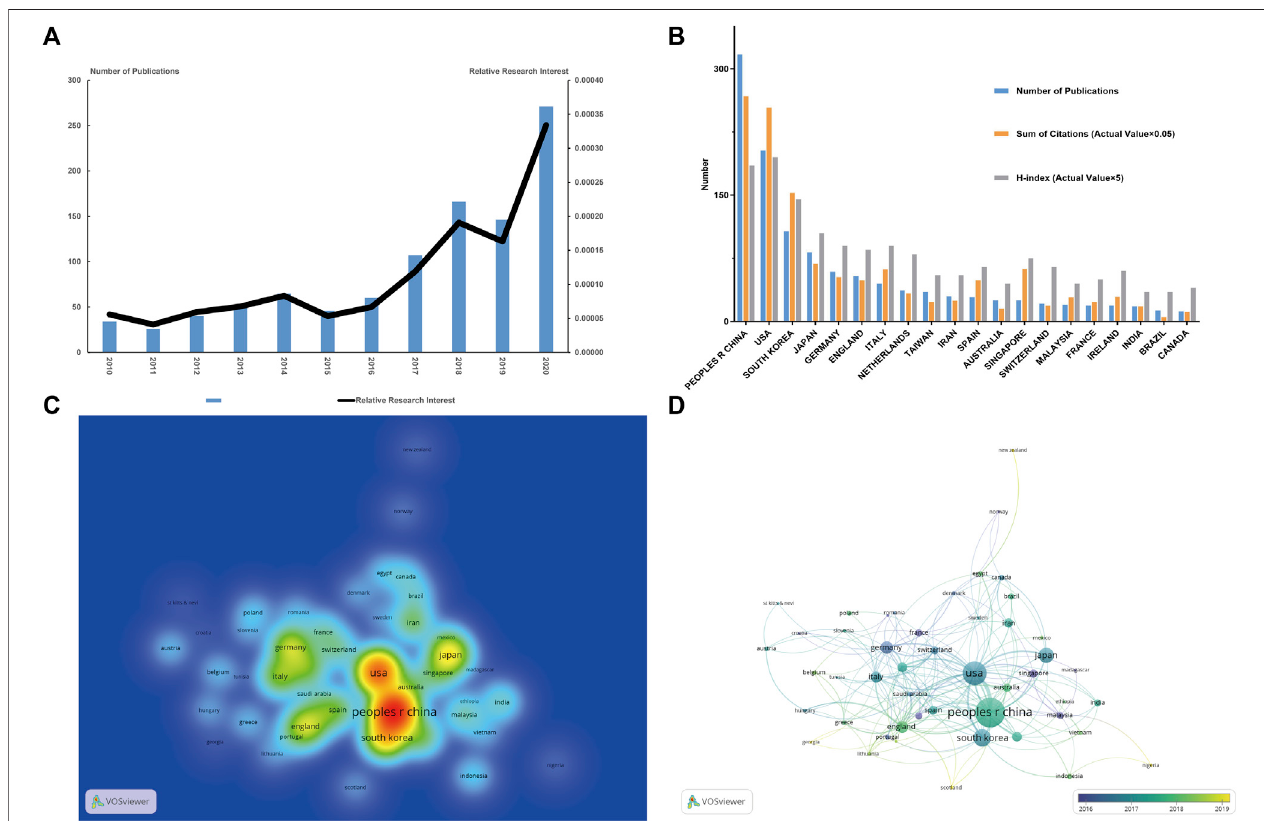
FIGURE 2 | Articles related to stem cells for cartilage regeneration published worldwide . (A) Annual publications worldwide and the relative research interest (RRI) for stem cells for cartilage regeneration. (B) The number of publications, citation frequency (actual value × 0.05), and H-index (actual value × 5) in the top 20 countries or regions. (C) Density map of regional distribution of articles based on VOSviewer. (D) Collaboration between countries or regions based on VOSviewer.